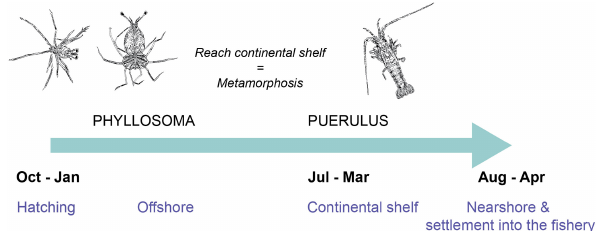
Figure 1. Early life cycle schematic of P. cygnus . Below the ar- row indicates each stage’s approximate timing (black) and location (blue). Above the arrow displays their growth, image credit Alice Ford.